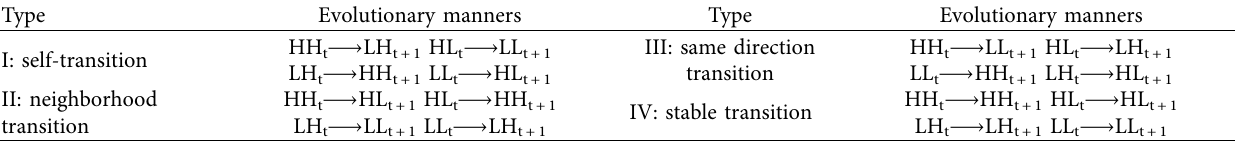
Table 1: Basic classification types of spatiotemporal transition of construction industry development.